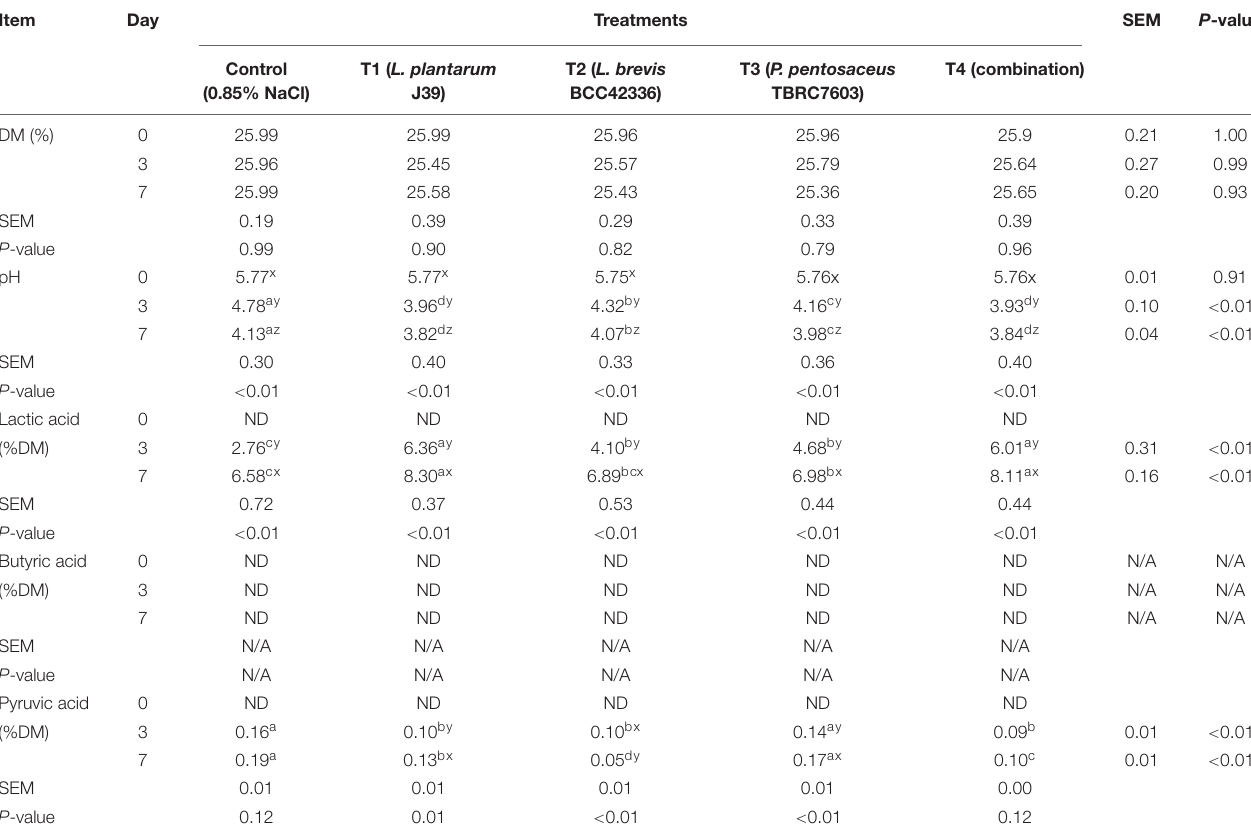
TABLE 3 | Fermentation quality of Napier grass silage during the ensiling process.